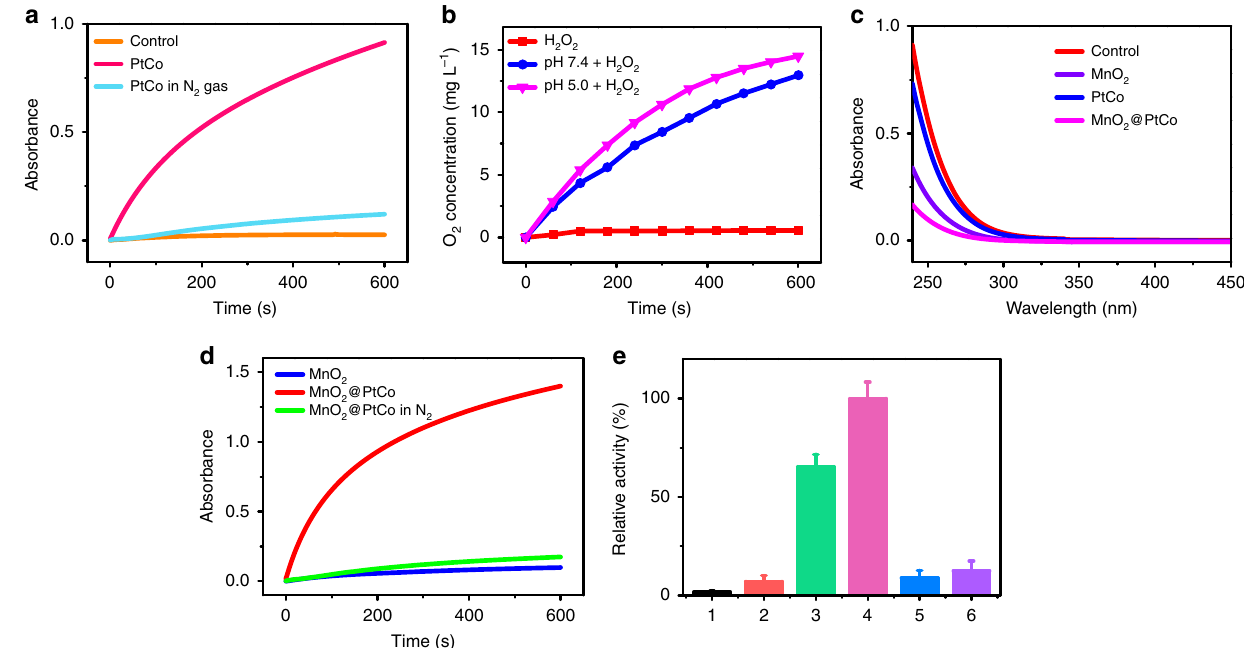
Fig. 2 Multi-enzyme activity of MnO 2 @PtCo nano fl owers in normoxia. a The study of PtCo nanozymes ’ oxidase-like activity. Time-dependent absorbance changes at 652 nm of TMB in the presence of PtCo at N 2 gas (mimicking hypoxic condition) or not. b Oxygen generation in H 2 O 2 solution with MnO 2 added under different pH values (7.4 and 5.0). c The study of MnO 2 component ’ s CAT-like activity. UV – vis spectra of remain H 2 O 2 were recorded after reacting with different nanomaterials. d The study of MnO 2 @PtCo nano fl owers ’ oxidase-like activity. Time-dependent absorbance changes at 652 nm of TMB with different treatments. e The qualitative analysis of different nanomaterials ’ oxidase activity. 1: control; 2: MnO 2 ; 3: PtCo; 4: MnO 2 @PtCo; 5: PtCo in N 2 gas; 6: MnO 2 @PtCo in N 2 gas. Data were presented as mean ± s.d. ( n =